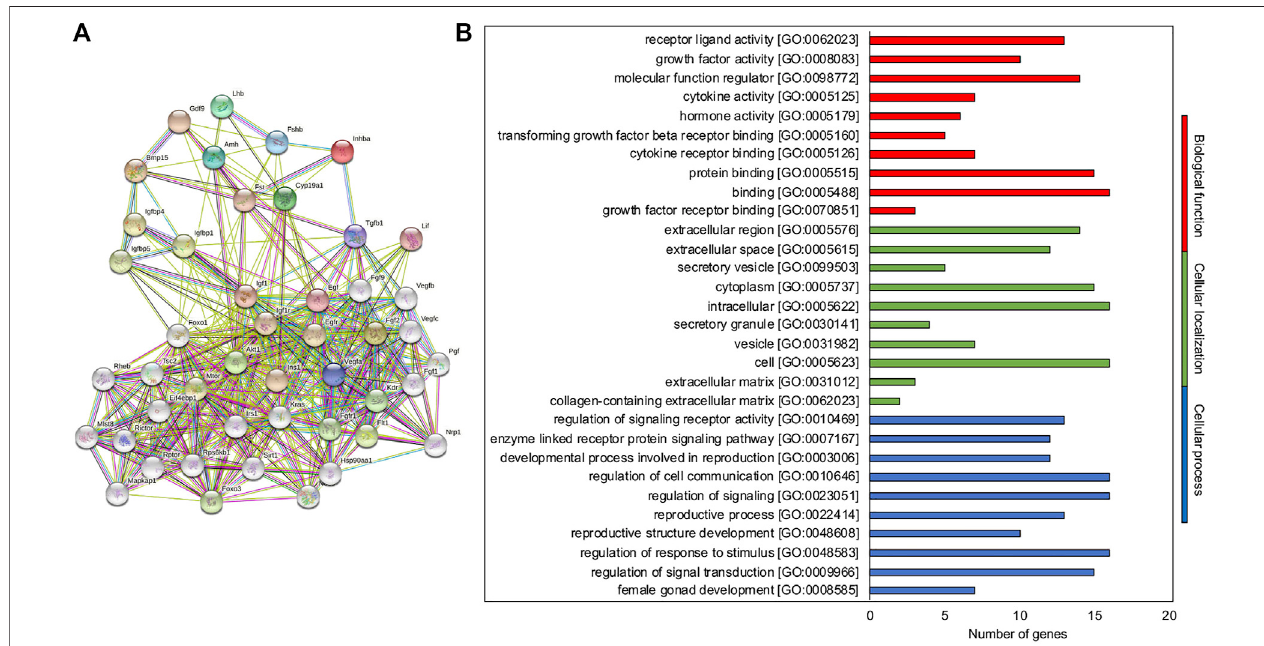
FIGURE 4 | STRING-MMivF as the interaction network tuning the ivF process. (A) Known and predicted protein – protein interactions related to the hub.BN molecules of the network. The interactions include direct (physical) and indirect (functional) associations; they stem from computational prediction, from knowledge transfer between organisms, and from interactions aggregated from other (primary) databases. (B) Representative scheme of the top 10 most abundant GO terms identi fi ed for the new interactor molecules in the three GO categories: biological function (red), cellular localization (green), and biological processes (blue). The x -axis indicates the number of new interactor molecules in a speci fi c category, while the y -axis indicates different GO terms.